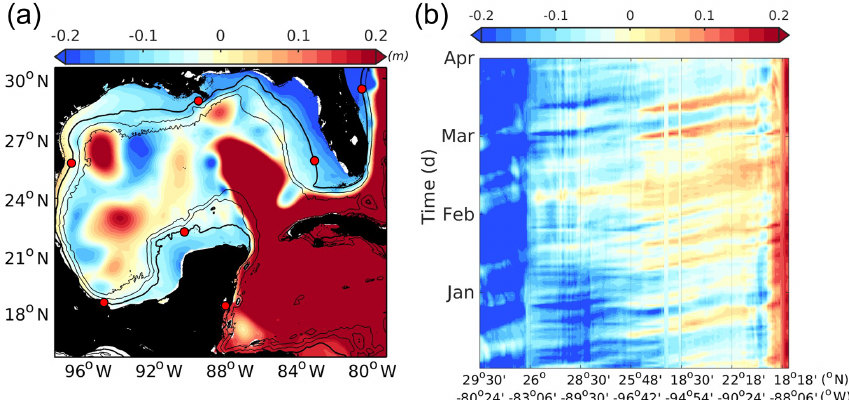
Figure 11. (a) Snapshot of sea level anomaly ( η , m) for the simulated year 2005. (b) Hovmöller diagram of η along the 50m isobath from January to April of the year 2005. Red dots in (a) denote the latitude and longitude shown at the bottom of (b) , from Florida to the Yucatán